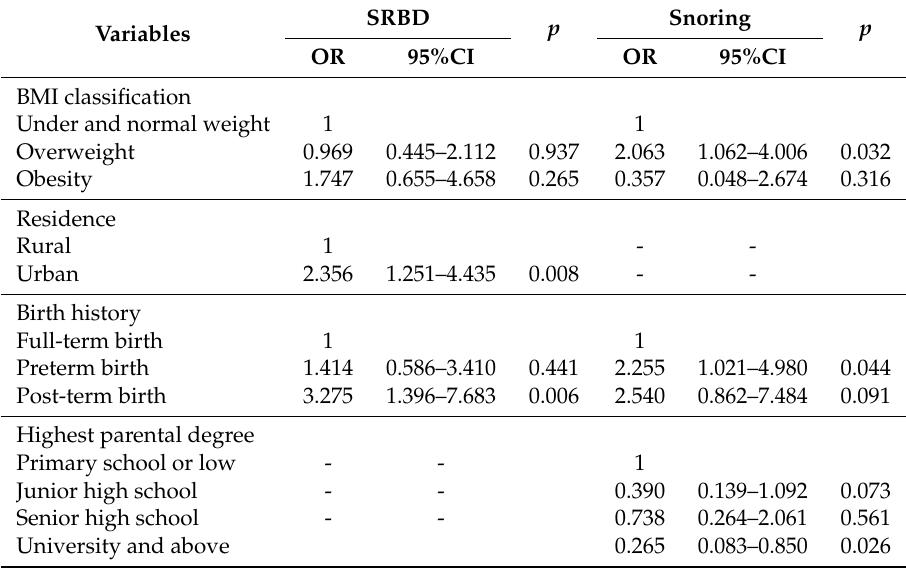
Table 4. Multivariate logistic regression analyses of risk for SRBD and